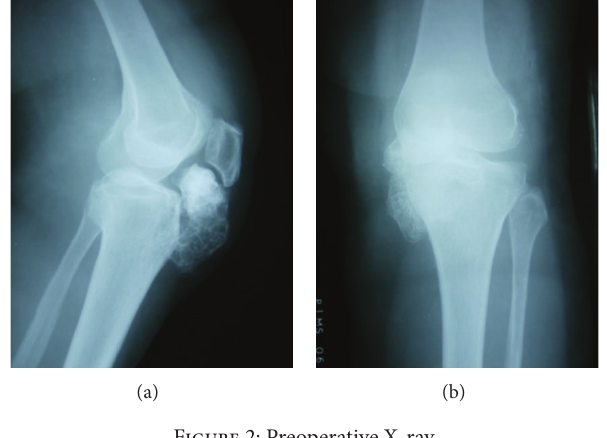
Figure 2: Preoperative X-ray.